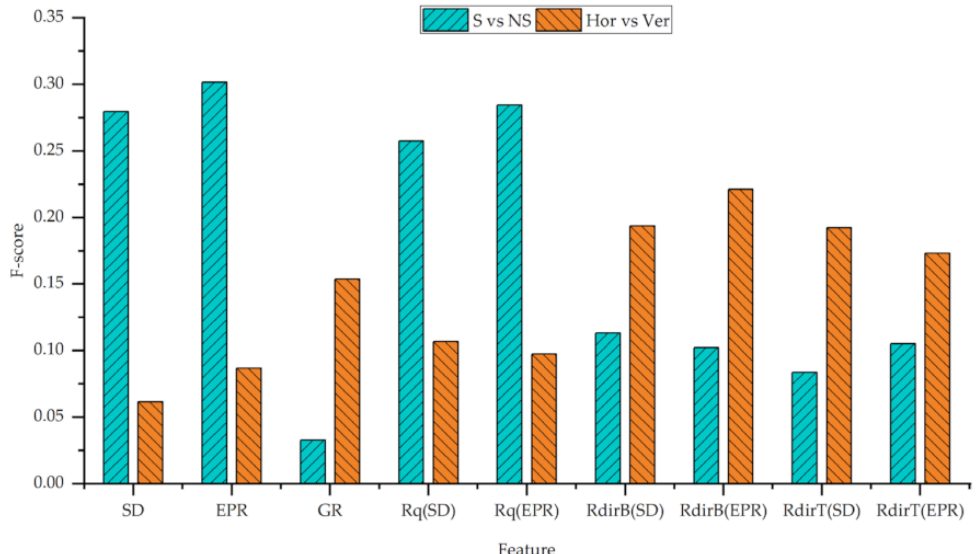
Figure 7. F-score of features for SVM classifiers S vs. NS and Hor vs.